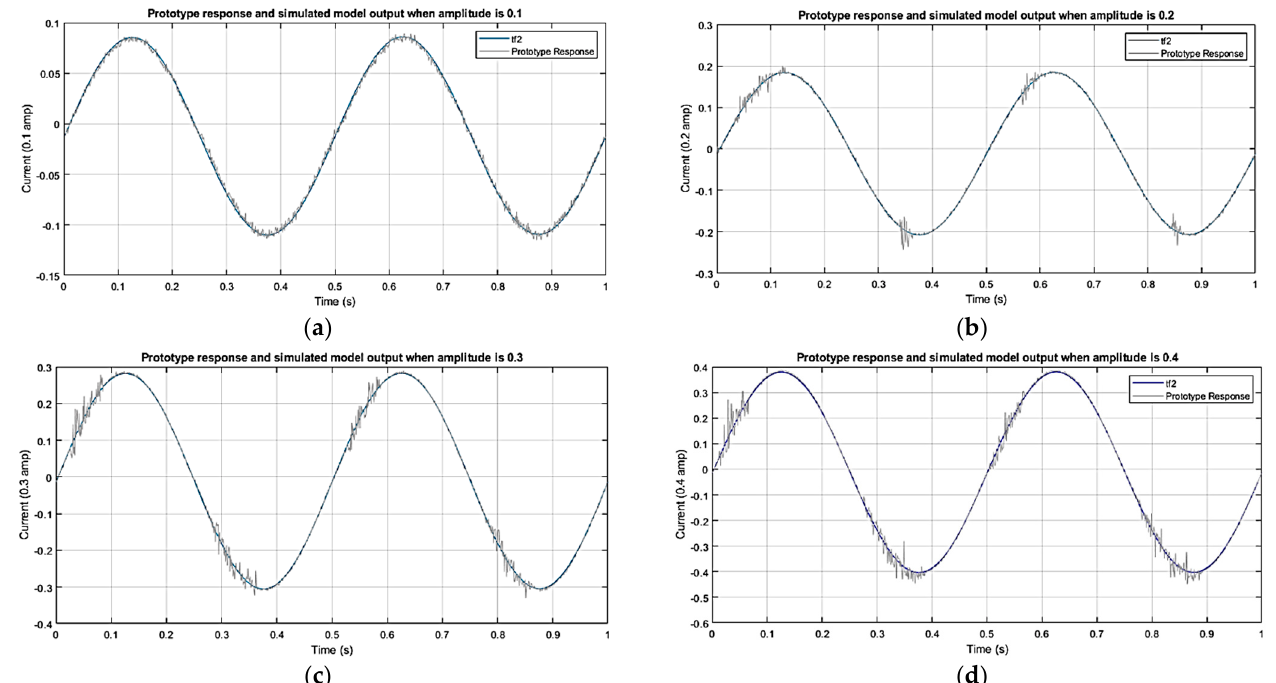
Figure 4. Prototype response and Model 2 response in amplitudes ( a ) 0.1 amp, ( b ) 0.2 amp, ( c ) 0.3 amp and ( d ) 0.4 amp.